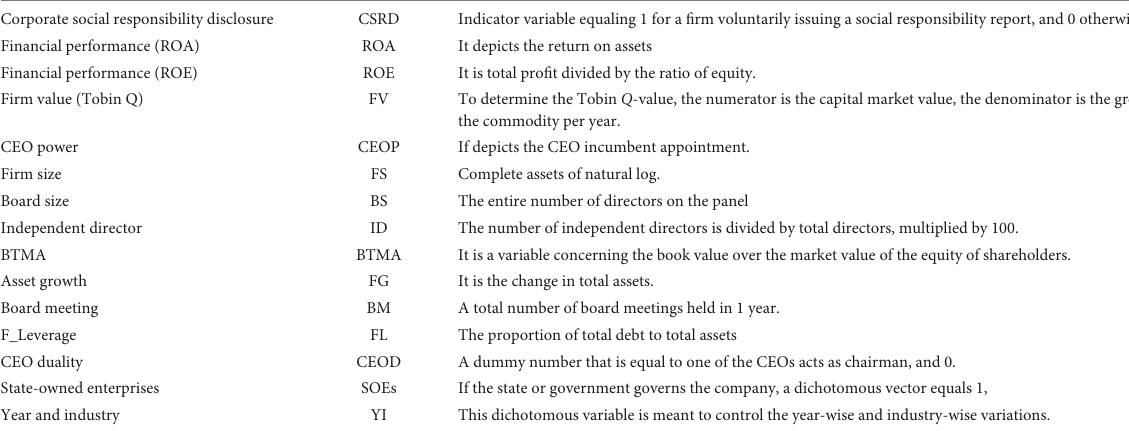
TABLE 2 Description of